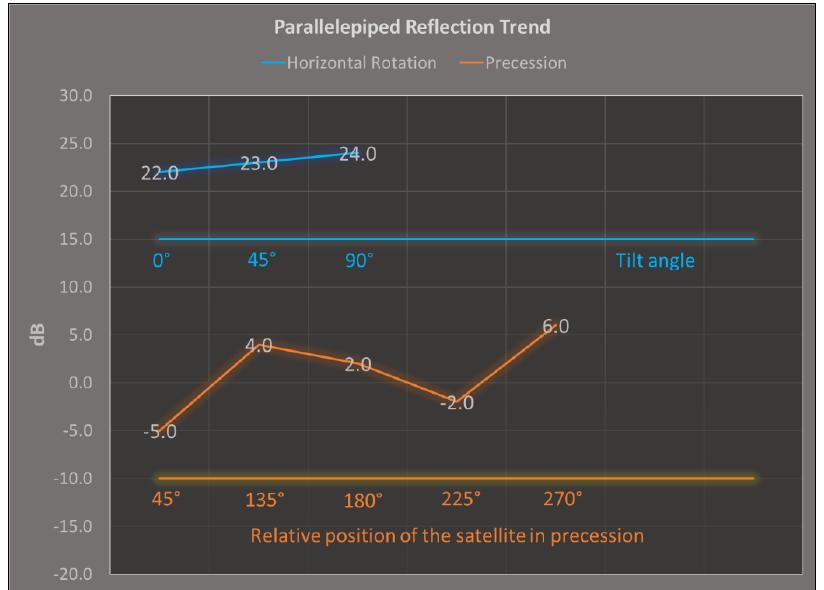
Figure 8. Parallelepiped reflection trend.